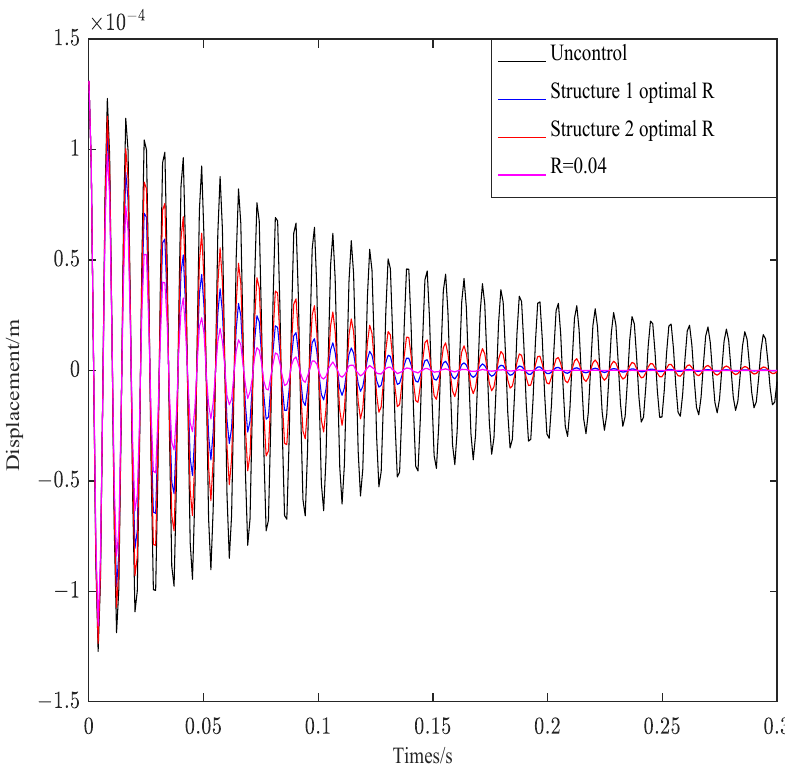
Figure 8. Effect of parameter R on structure 1.